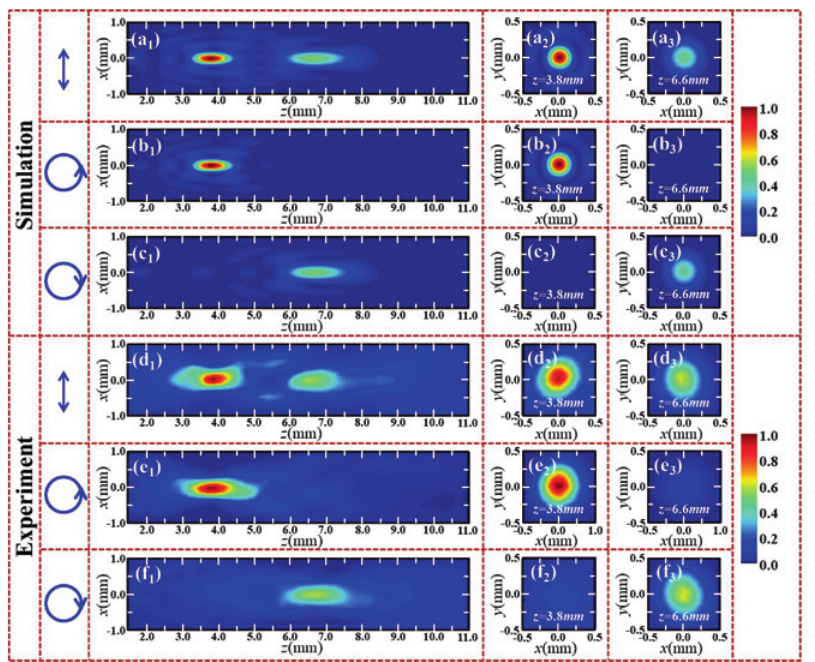
THz waves. (a 2 ∼ c 3 ) The corresponding electric fi eld distributions in the x - y plane THz waves. (d 1 ∼ f 3 ) Corresponding